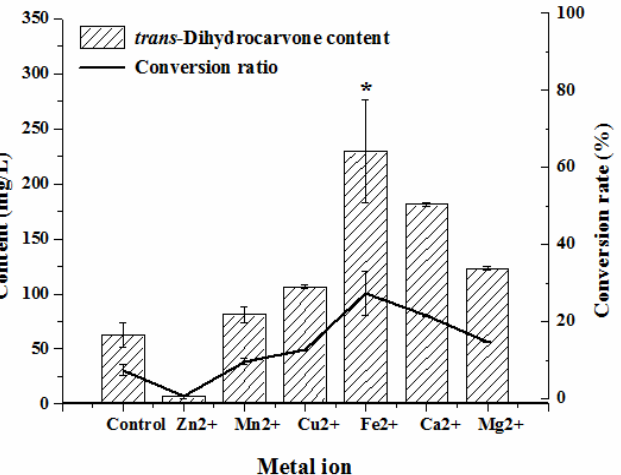
Figure 5. Effect of metal ions on the production of trans -dihydrocarvone by Klebsiella sp. O852 (cultivation conditions were at 30 ◦ C and 150 rpm, limonene of 840 mg/L was added as substrate) * p < 0.05 vs. control group.